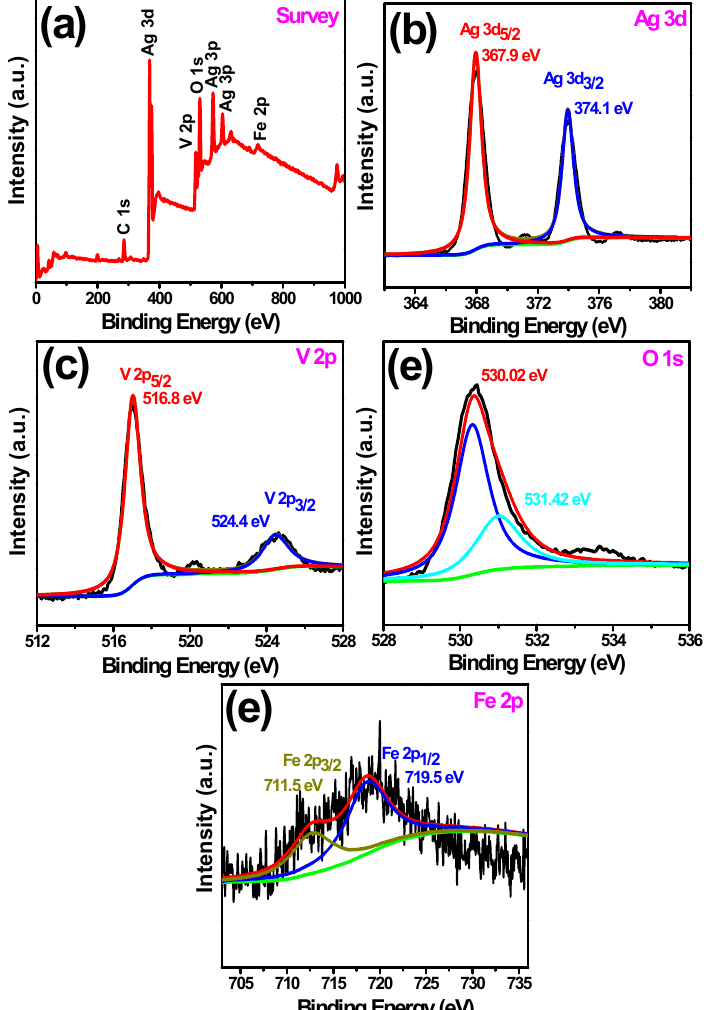
Figure 7. X-ray photoelectron spectra (XPS) of the optimized FeAVO-3 nanocomposite photocatalyst: ( a ) Full survey spectrum, ( b ) Ag 3d, ( c ) V 2p, ( d ) O 1s and ( e ) Fe 3d.